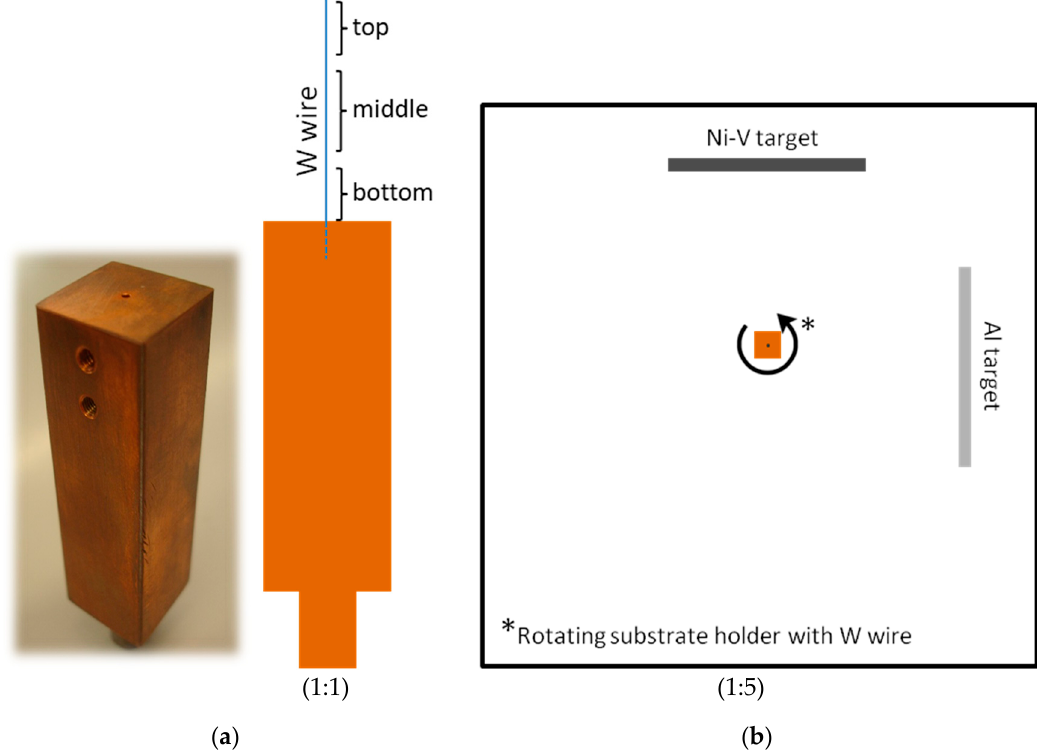
Figure 1. ( a ) Copper substrate-holder showing the hole at the top surface where the W wire is introduced, and ( b ) schematics of the deposition chamber top